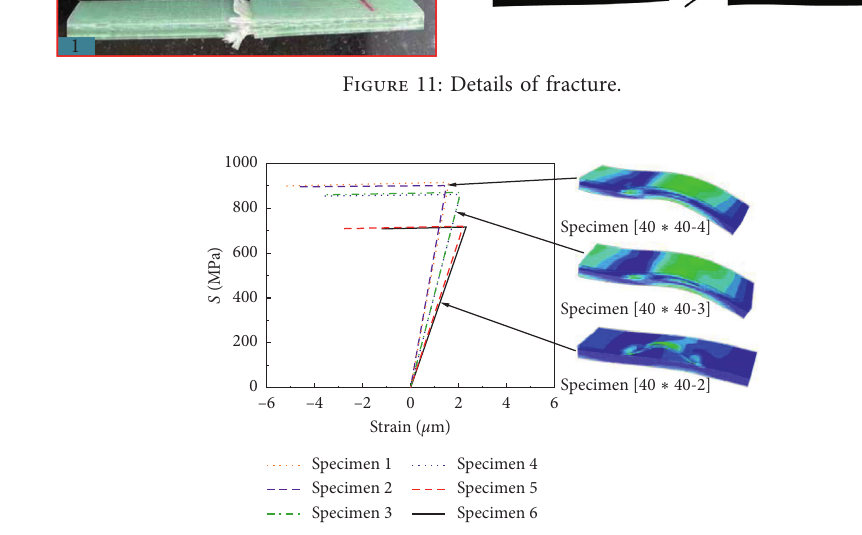
Figure 12: Materials behavior of tested